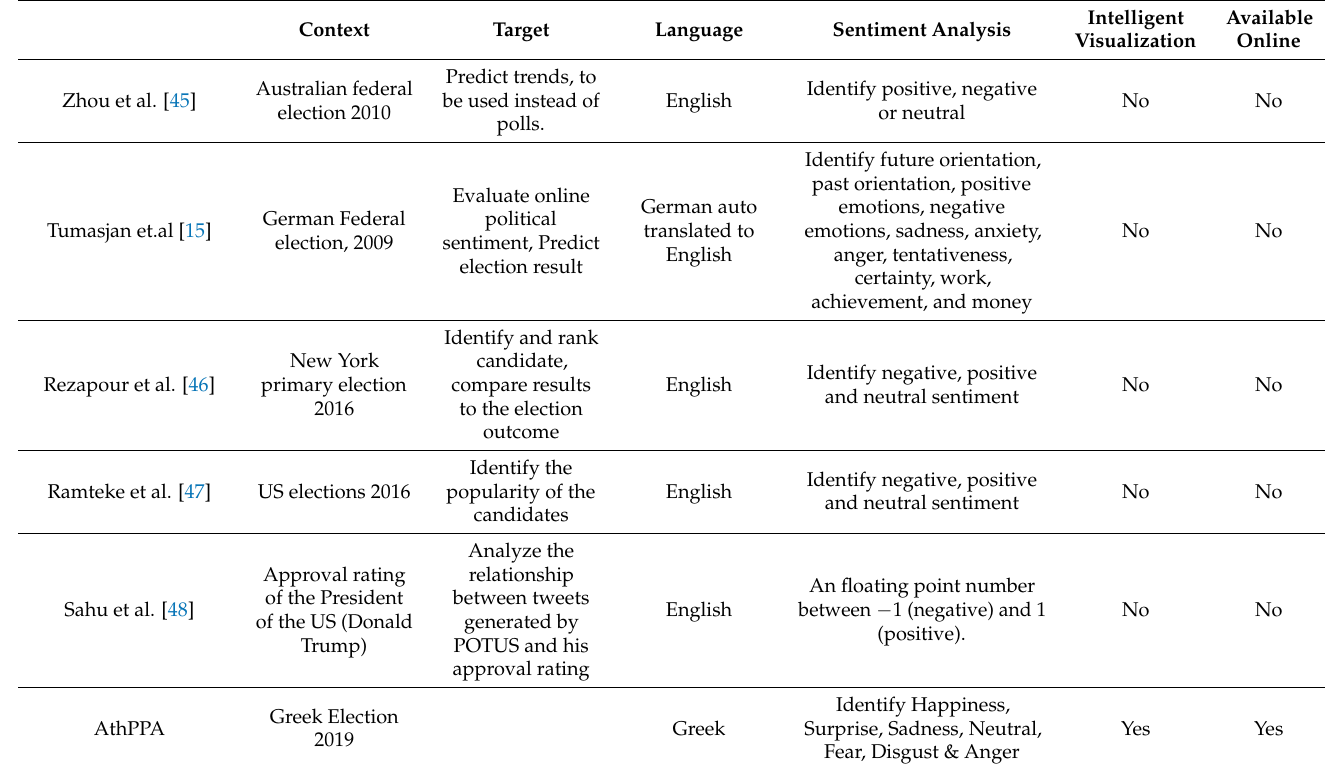
Table 1. Comparison of the works focusing on sentiment analysis for political